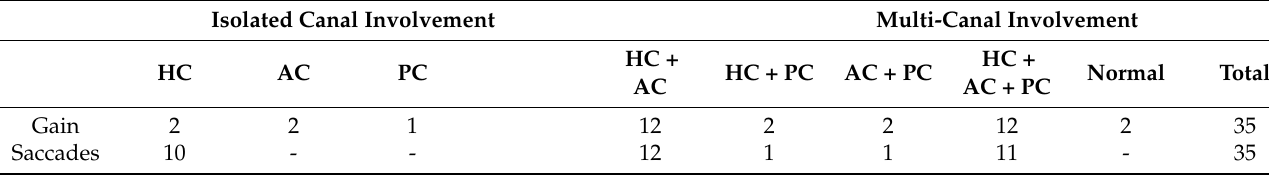
Table 4. Isolated and multi-canal involvement according to vHIT parameters (gain, covert saccades, and overt saccades) at the acute stage of vestibular neuritis (affected side). HC: horizontal canal plane, AC: anterior canal plane, PC: posterior canal